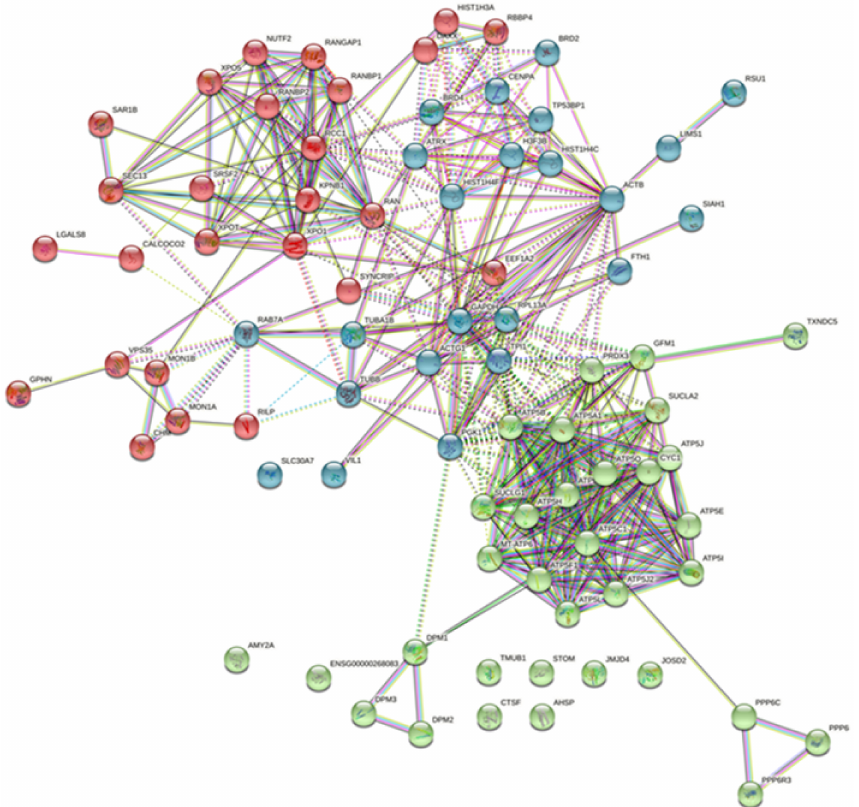
Figure 7. Protein–protein interaction (PPI) maps of prey proteins for bait ORF25. Network nodes represent proteins. Edges represent protein–protein associations, edges between clusters are dotted lines. Different colors represent three clusters that were distinguished by the K-means method, and the gene name information was listed in Supplementary Table